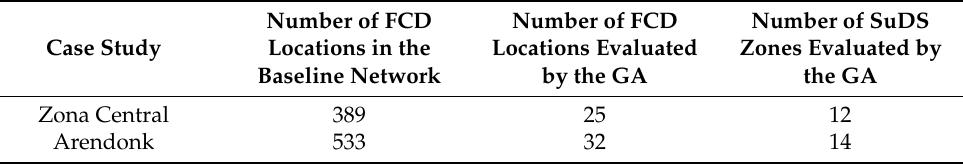
Table 2. Number of SuDS zones and FCD locations tested by the GA for each case-study catchment that was